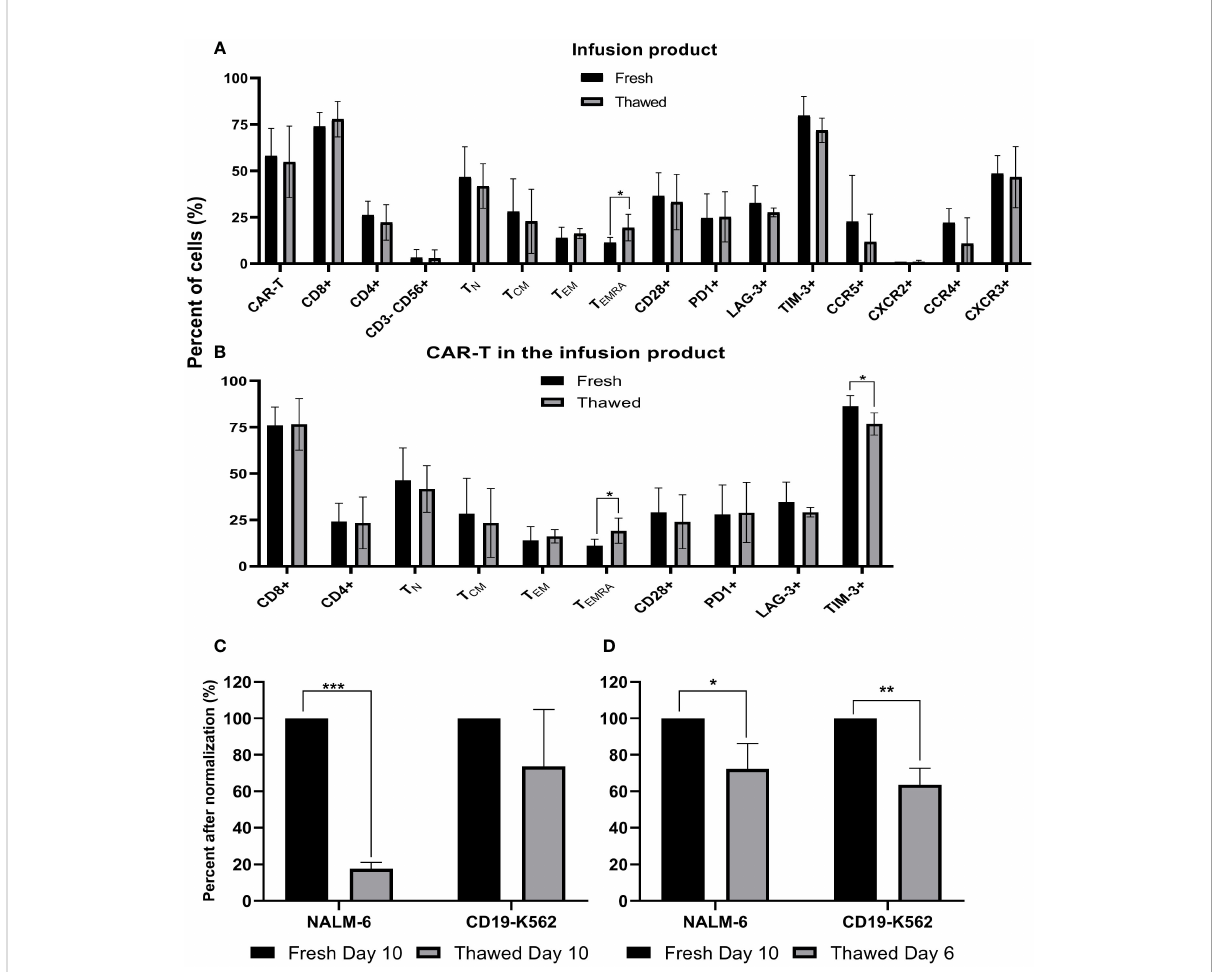
FIGURE 3 Phenotype analysis and anti-tumor reactivity of cryopreserved infusion products. (A) Fresh CAR T infusion products were characterized by fl ow cytometry before cryopreservation and after thawing (n=5). NK cells, CD3-CD56+; TN (naïve), CD3+ CD45RA+ CCR7+; TCM (central memory), CD3+CD45RA − CCR7+; TEM (effector memory), CD3+CD45RA − CCR7 − ; TEMRA (effector), CD3+ CD45RA+ CCR7. (B) Phenotype analysis of the CAR T infusion products gated on CD3+F(ab)2+ CAR T cells (n=5). (C+D) Cell potency determined as IFN g secretion after co-culture with CD19 expressing target cell lines (NALM-6, CD19-K562). The IFN g levels are shown after normalization (fresh CAR T, day 10 = 100%) (n=3). (C) Fresh and cryopreserved CAR T cells from day 10. (D) Fresh CAR T cells from day 10 and cryopreserved CAR T cells from day 6, which were thawed 4 days later. *p ≤ .05, **p ≤ .01, ***p ≤